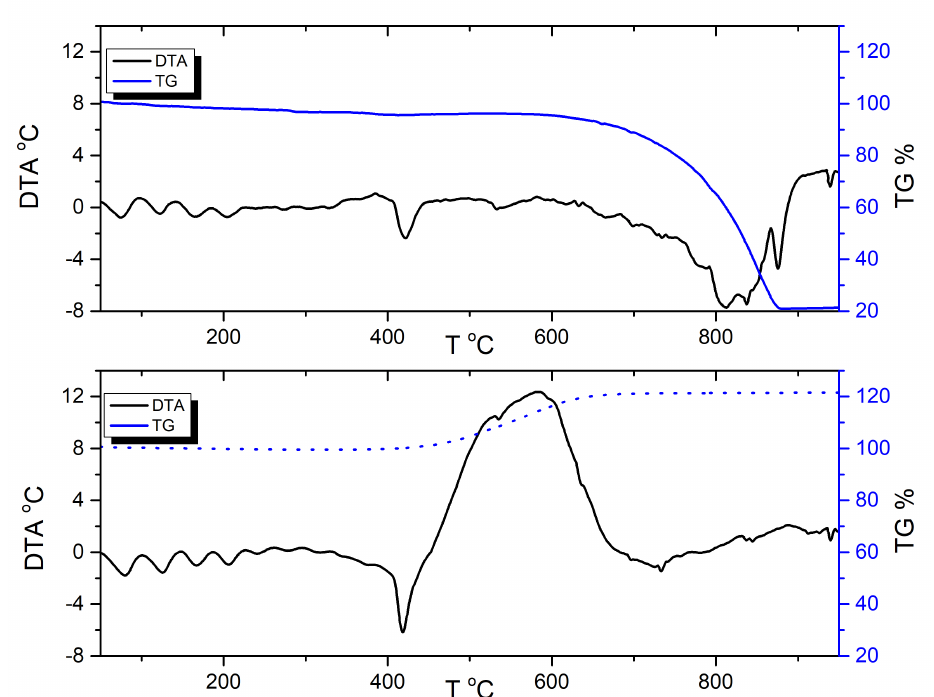
Figure 1. DTA and TG curves for KMnO 4 . Thermogravimetric DTA/TG of zinc were conducted under air and argon flow (Figure 2). Expectedly, regardless of utilised gas, the melting of Zn was observed at approx. 420 ◦ C, consistent with literature data [32]. Further heating in argon showed a strong endothermic peak accompanied by mass loss, consistent with gradual vaporisation and boiling of zinc. In the case of heating in air, an opposite phenomenon—an exothermic peak accompanied by mass increase—was observed, corresponding to gradual oxidation of Zn to ZnO.